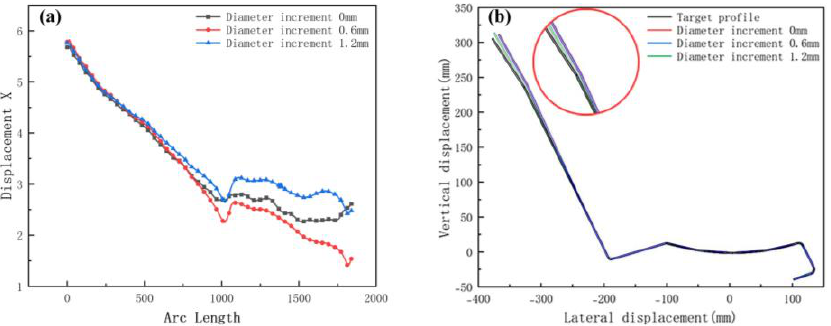
Figure 17. Longitudinal strain of strip in 3 diameter increments.